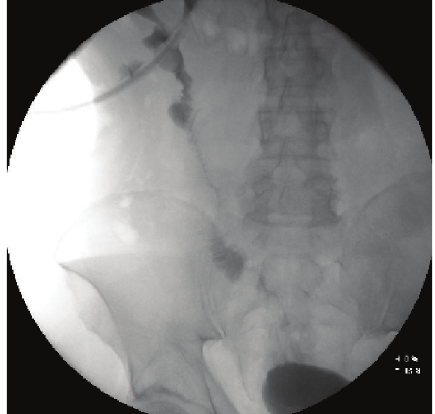
Figure 3: Nephrostogram.